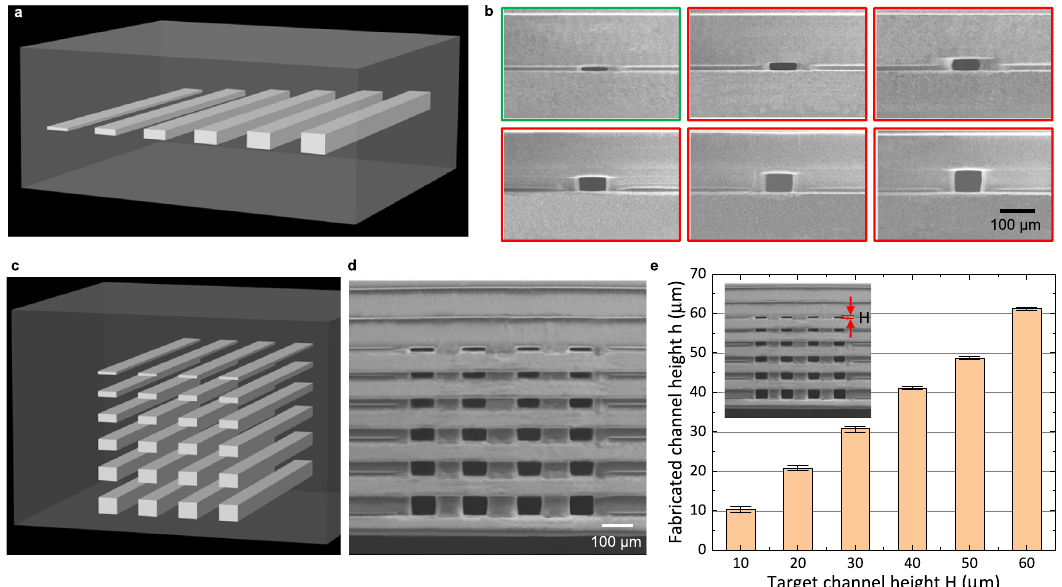
Fig. 3 Fabrication of micro fl uidic channels via IsT-VPP. a CAD model of the part with single-layer micro fl uidic channels embedded. The channel heights range from 10 µ m to 60 µ m. b SEM images of micro fl uidic channel cross-section. The channel circled by green has 10 μ m in height. Such a channel is fabricated when connected with the previously built part corresponding to Fig. 2 g. The channels circled by red with heights of >10 μ m are manufactured using the main build platform corresponding to Fig. 2e except for the last 10 μ m layer. c CAD model of the part with multiple layer micro fl uidic channels. The channel heights range from 10 μ m to 60 μ m. d SEM image of the multi-layer micro fl uidic channel cross-section. e Statistical results of the fabricated channel